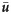
Tradeoff for all sites between bird sensitivity and wind profitability as net present value (NPV) in $US millions.Sites with negative NPV were excluded from this plot. Values were rescaled before calculating average utility (u¯) of each site from 11 simulations of the utility function ranging a in Equation 8 from 0 to 1. The slope of the median a˜ is shown as a dotted line passing through the highest utility site E. The red quadrant corresponds to the sites with the least 20% of profitability or the most 20% of bird sensitivity. The upper right blue quadrant corresponds with sites excluding the 60% least profitable and 60% most sensitive, hence a preferred subset for development of offshore wind energy.